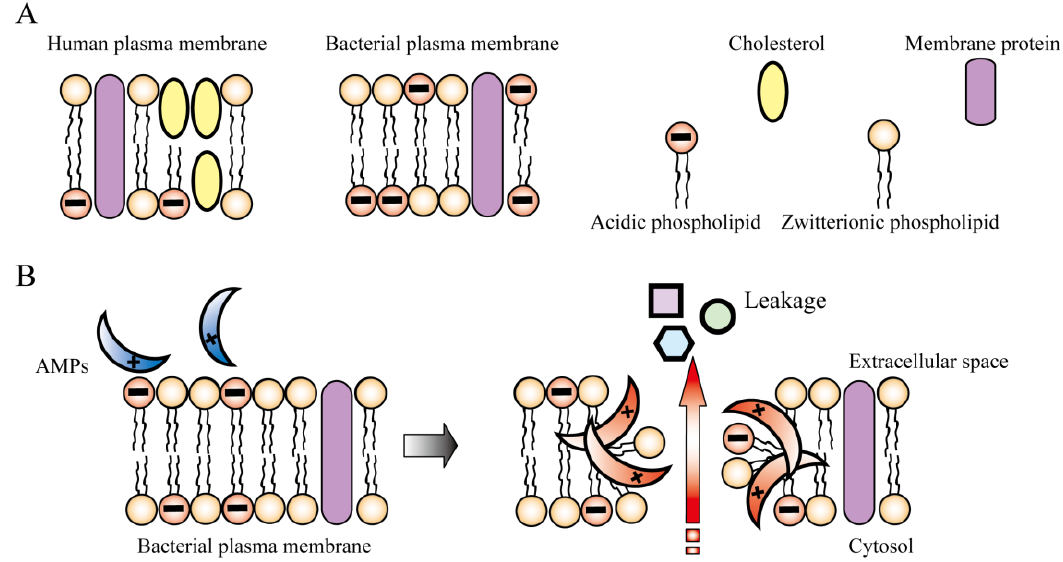
Figure 2. Mechanism of action of antimicrobial peptides (AMPs). ( A ) Comparison of human and bacterial plasma membranes. ( B ) Disruption of bacterial membrane by AMPs. AMPs preferentially interact with bacterial plasma membrane due to their electrical